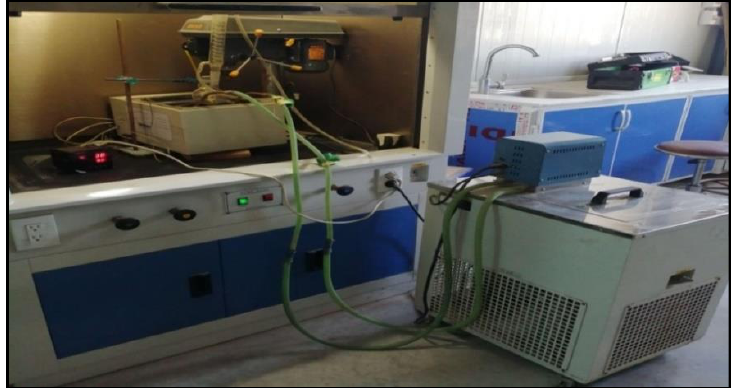
Fig. 1 . Photographic picture of the apparatus used for preparation graphene